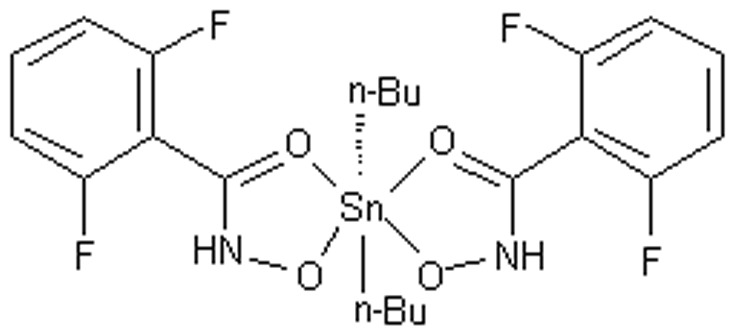
Structure of DBDFT.